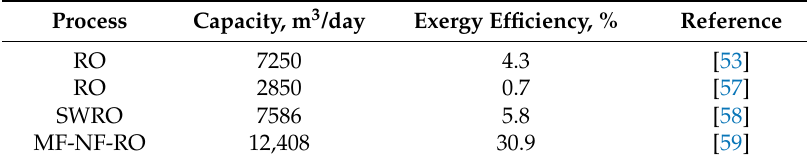
Figure 10. Exergy efficiencies of integrated SWRO units with and without ERDs. Table 6. Exergy efficiency of reverse osmosis processes.